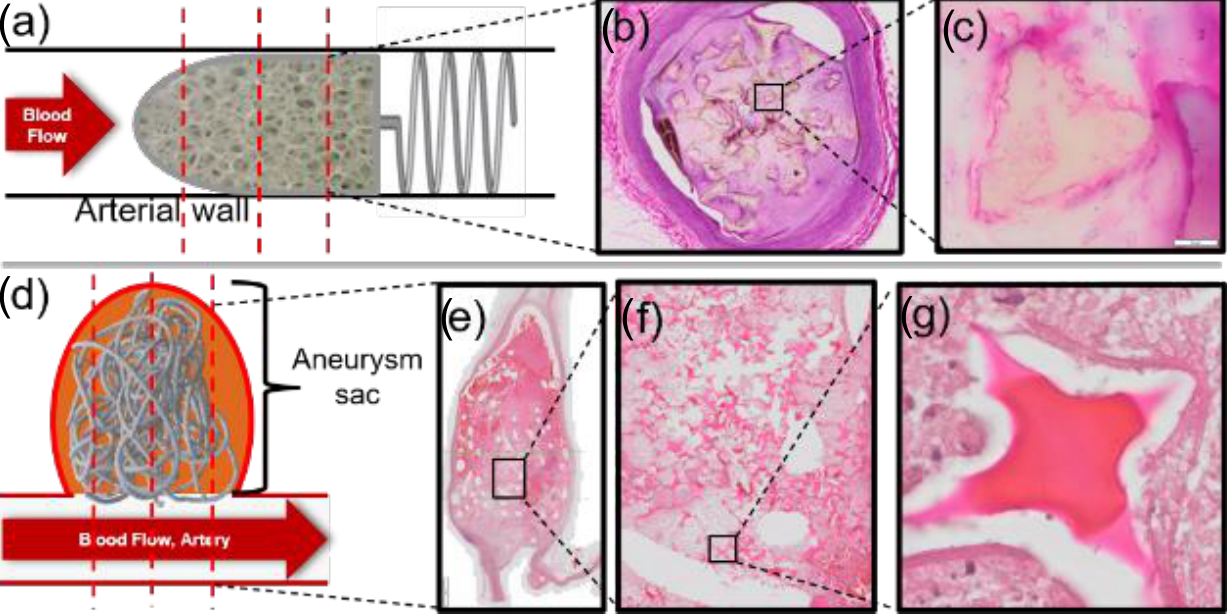
Figure 2. PED devices were deployed in the porcine vasculature with the foam directly in flow and the nitinol coil distal to the entry of blood ( a ). NED devices were deployed in the rabbit elastase aneurysms to fill the space — multiple devices were used of different sizing ( d ). Histological trans- sections of the explanted device(s) in tissue were scanned at high resolution and magnification ( b , e ). The red line denotes the general location of slices ( a , d ). Struts and membranes were analyzed for degradation ( c , f , g ). 2X magnification ( b , e ), 10X magnification ( f ), and 100X magnification ( c , g ) (20 μm) .